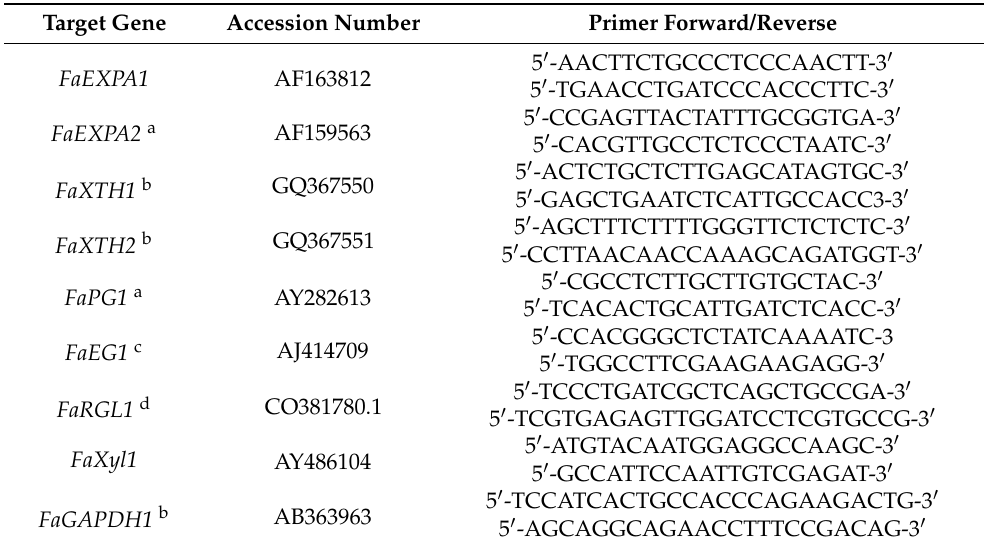
Table 1. Primers sequences (5 (cid:48) → 3 (cid:48) ) used in this study to real-time PCR (RT-qPCR). Target